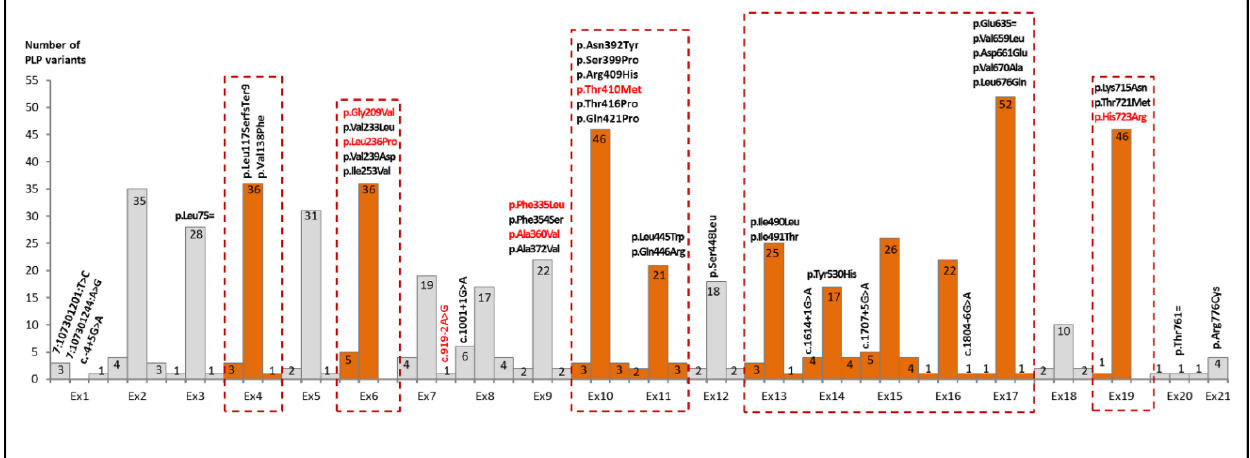
Figure 5. The regions of the SLC26A4 gene sequence with the highest diagnostic value. The exons with high rates of the PLP variants with adjacent intronic regions are marked in orange color and highlighted with a dotted line. The most common PLP variants ( n = 42, see in text and Table S2) are shown above the bars. Seven variants with both relatively high MAFs (>0.05%) and high mutation rates in patients are shown in red.